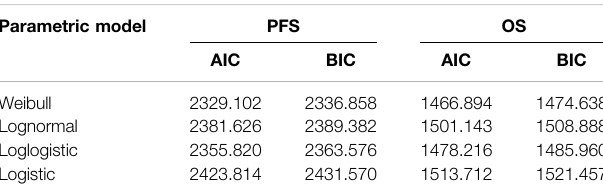
TABLE 2 | Parametric survival